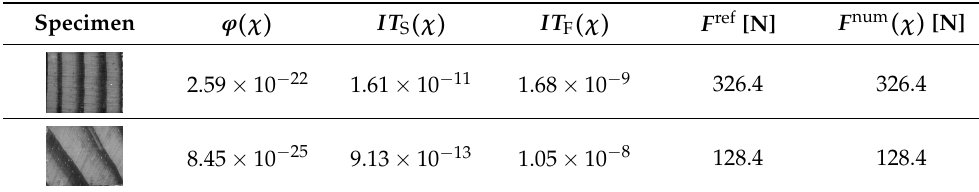
Table 4. Summary of FEMU parameters on the final iteration, for an on-axis and off-axis specimens using a DIC-levelled FEA reference.